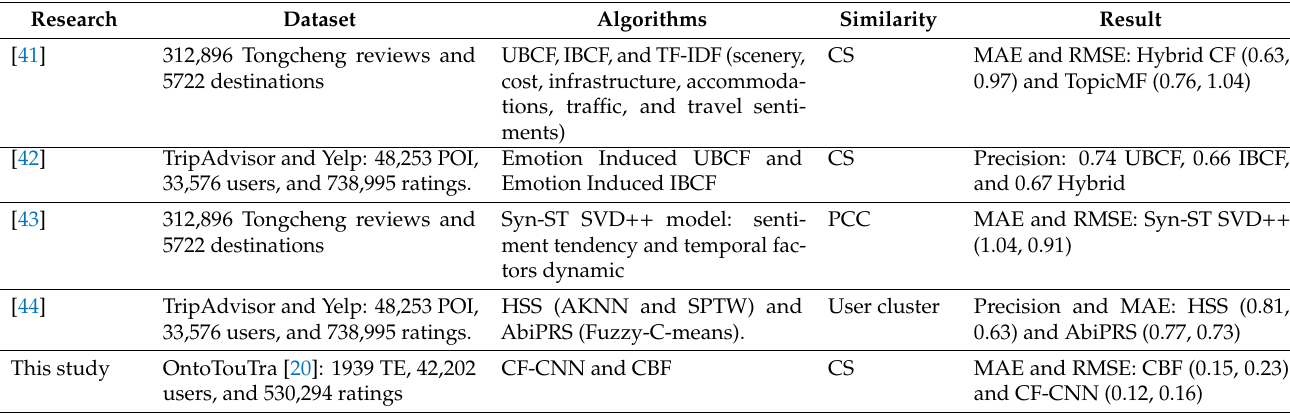
Table 3. Studies of recommendation systems based on